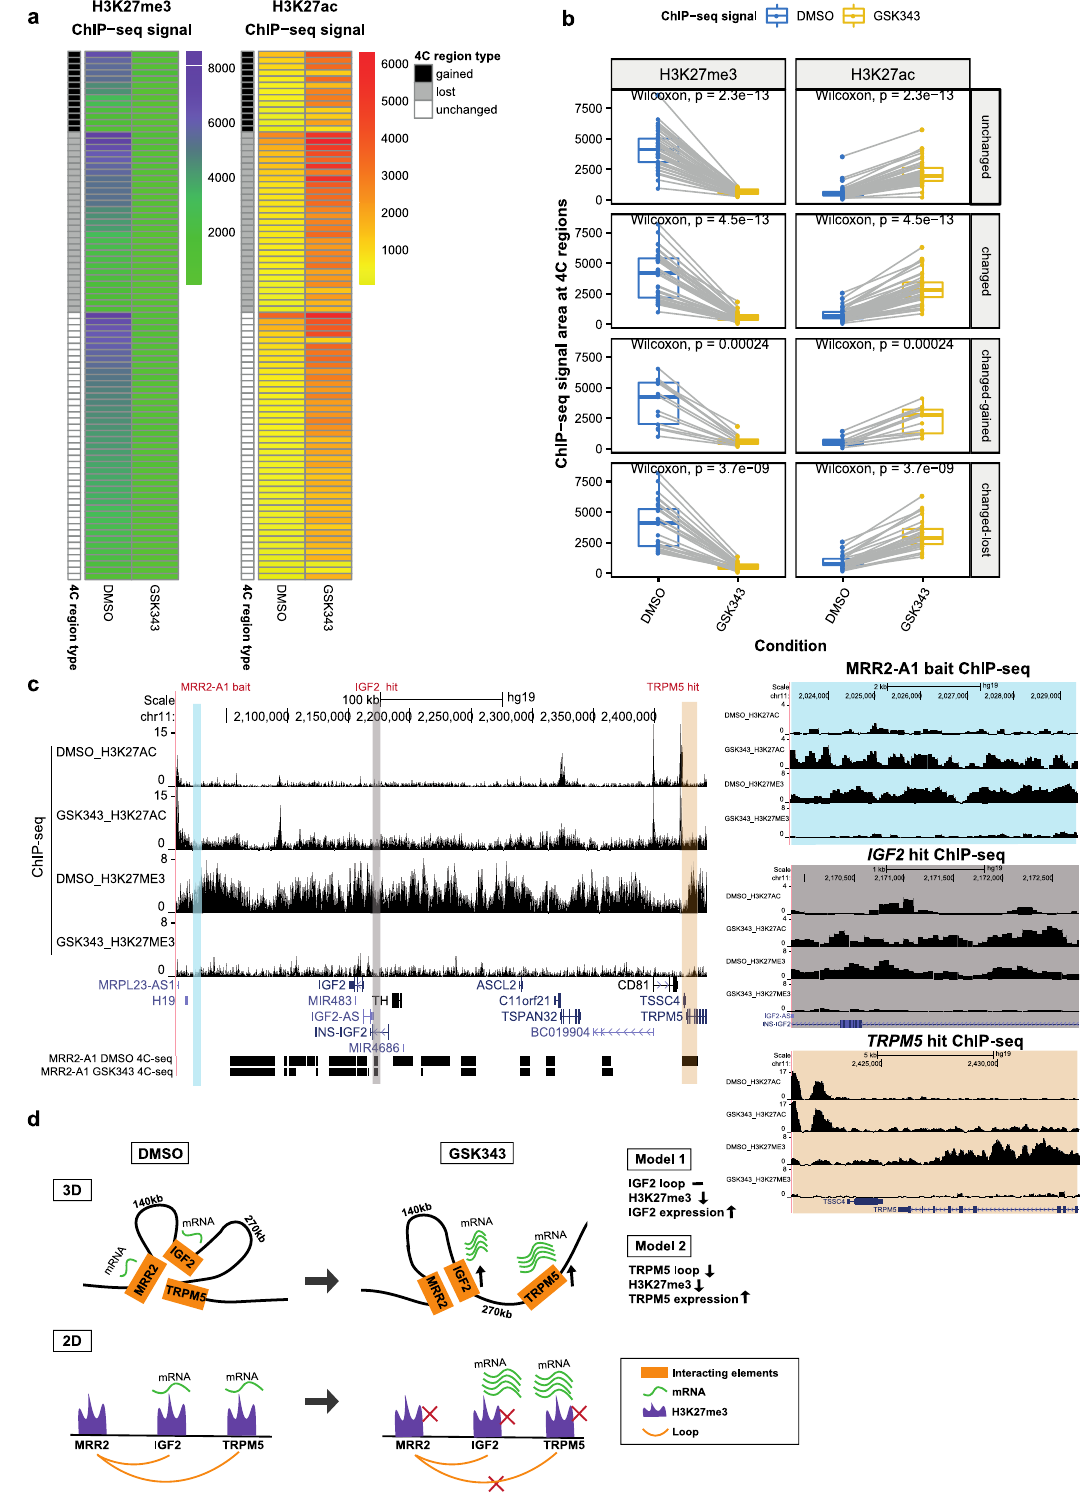
40) supplemented with protease inhibitors (Roche). First step digestion was per- formed overnight at 37°C with HindIII enzyme (NEB). Digestion ef fi ciency was measured by RT-qPCR with HindIII site-speci fi c primers. After con fi rmation of good digestion ef fi ciency, DNA was ligated overnight at 16°C by T4 DNA ligase (Thermo Scienti fi c) and de-crosslinked. Following de-crosslinking, DNA was extracted by phenol-chloroform and this is the 3C library. The DNA was then processed for second digestion with DpnII enzyme (NEB) overnight at 37°C. After fi nal ligation, 4C template DNA was obtained, and the concentration